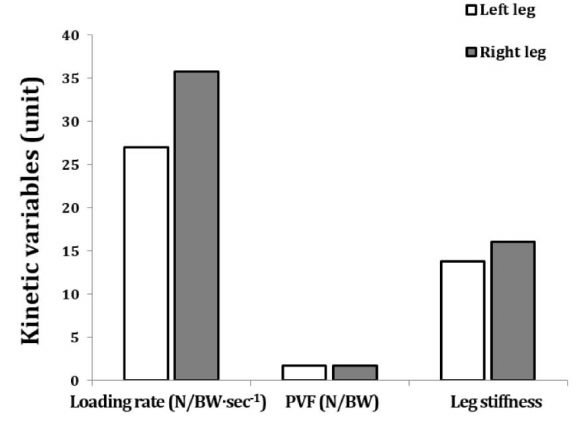
Fig. 4. Loading rate, PVF, and leg stiffness according to the landing